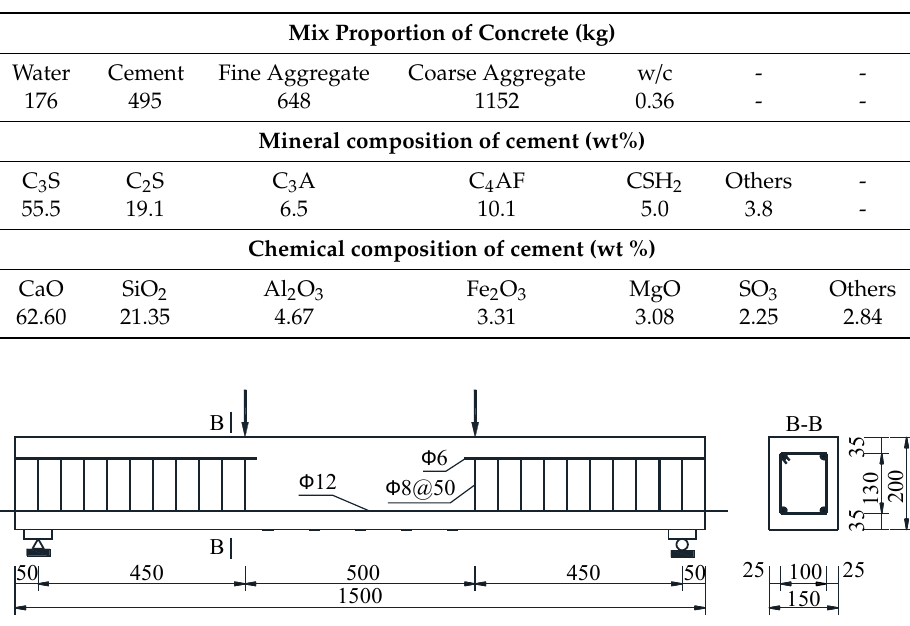
Figure 2. Typical dimensions and reinforcement details of the test specimens (mm).